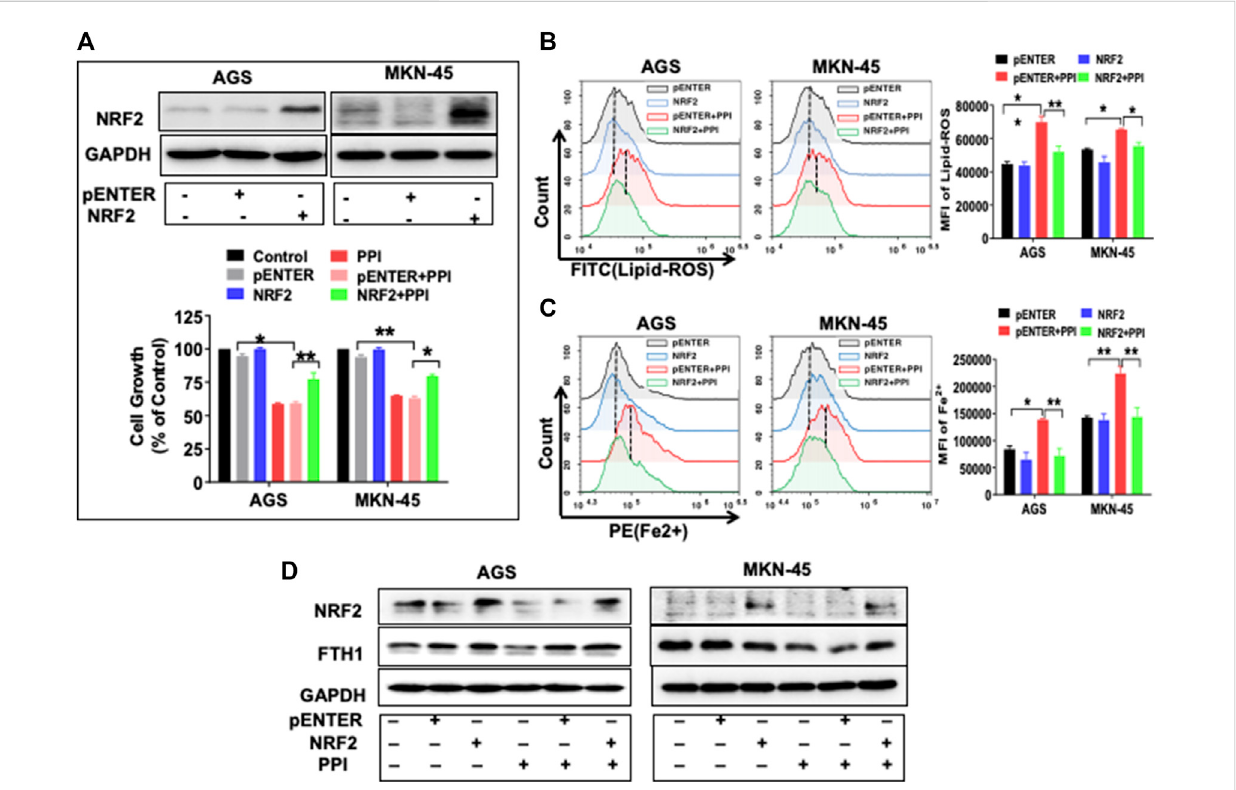
FIGURE 7 NRF2 overexpression reverses the effects of PPI on cell growth and ferroptosis in the gastric cancer cells. AGS and MKN-45 cells were transfected with NRF2 plasmid or the pENTER control vector for 24 h before they were exposed to PPI (3 μ M) for an additional 24 h (A) NRF2 expression was con fi rmed after the transfection, while cell growth was assessed using MTT assays. (B and C) The levels of intracellular lipid peroxides (lipid-ROS) and ferrous ions (Fe 2+ ) were detected using fl ow cytometry after the transfections and/or PPI treatment. Data are shown as mean ± SD while p values were determined through one-way ANOVA (* p < 0.05, ** p < 0.01, compared with pENTER-vector control). (D) The expression of NRF2/FTH1 was analyzed using Western blot. Shown is one set of two or three separate